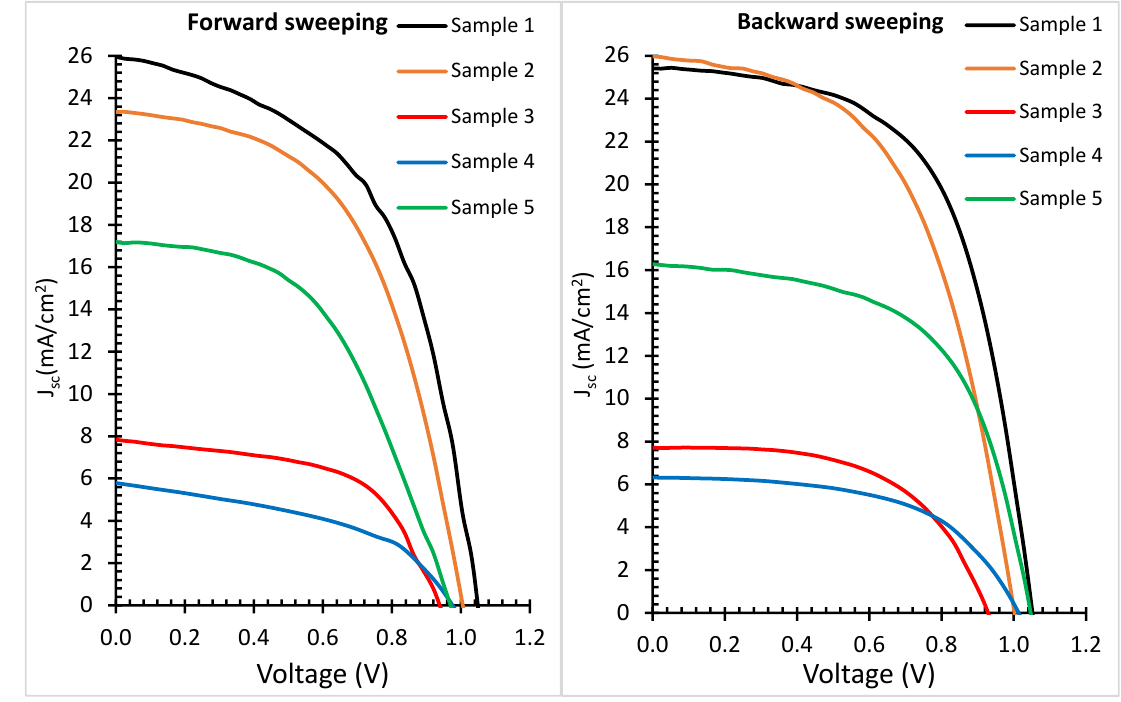
Figure 11. J − V characteristic curves of various compositions of the 5 perovskite solar cells: ( left ) forward sweeping; ( right ) reverse sweeping. The scan rate was 0.028 V/s.